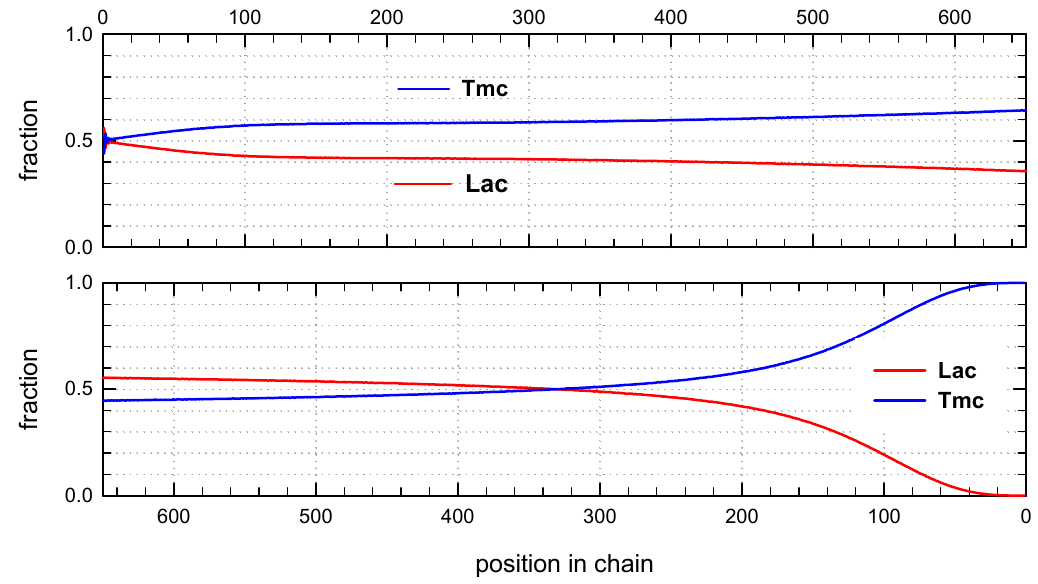
Figure 9. Distribution of copolymer units along an average chain expressed as mole fractions for system initiated with the mixture of Lac- S -Ini * and Tmc- S -Ini * unimers. The relative kinetic parameters as shown in Table 2 and caption to Figure 7. Unit positions numerated from chain beginning ( top box ) and from the chain-end ( bottom box ).